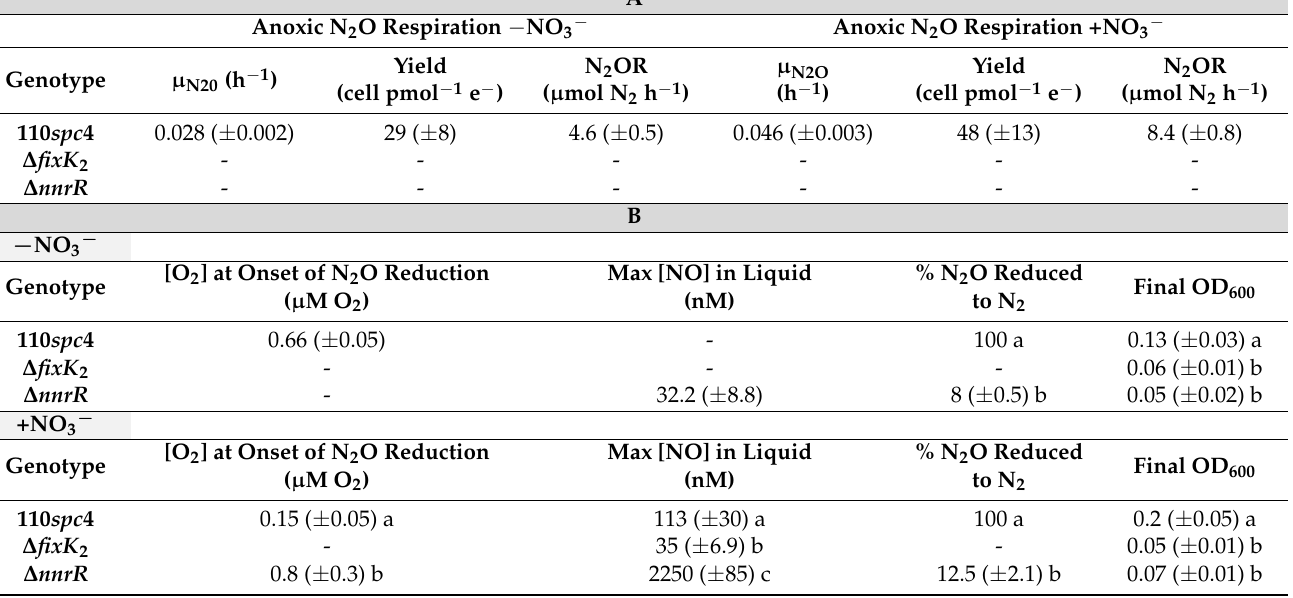
Table 2. Summary of growth parameters from N 2 O consumption in the B. diazoefficiens 110 spc 4 parental and fixK 2 and nnrR mutant strains ( A ) and other parameters observed through the incuba- tions, depending on the presence or absence of NO 3 − ( B